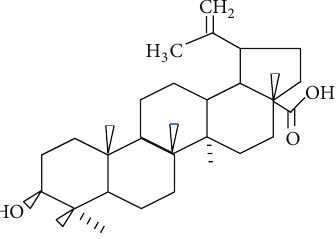
Figure 1: Chemical structure of betulinic acid.